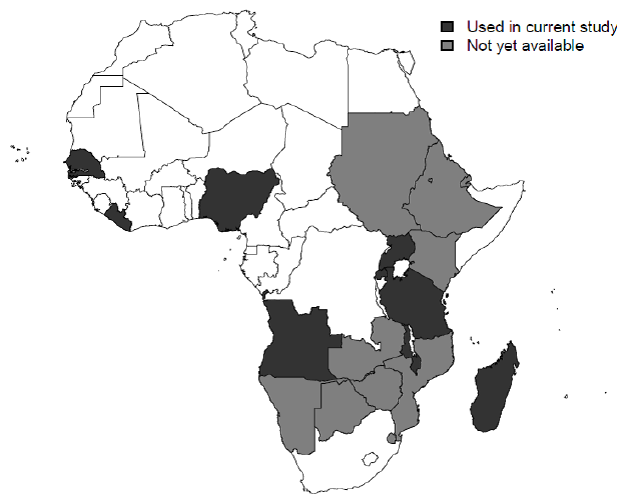
Fig. 1 . Map of Demographic and Health Surveys/Malaria Indicator Surveys included, and other surveys with information on malaria